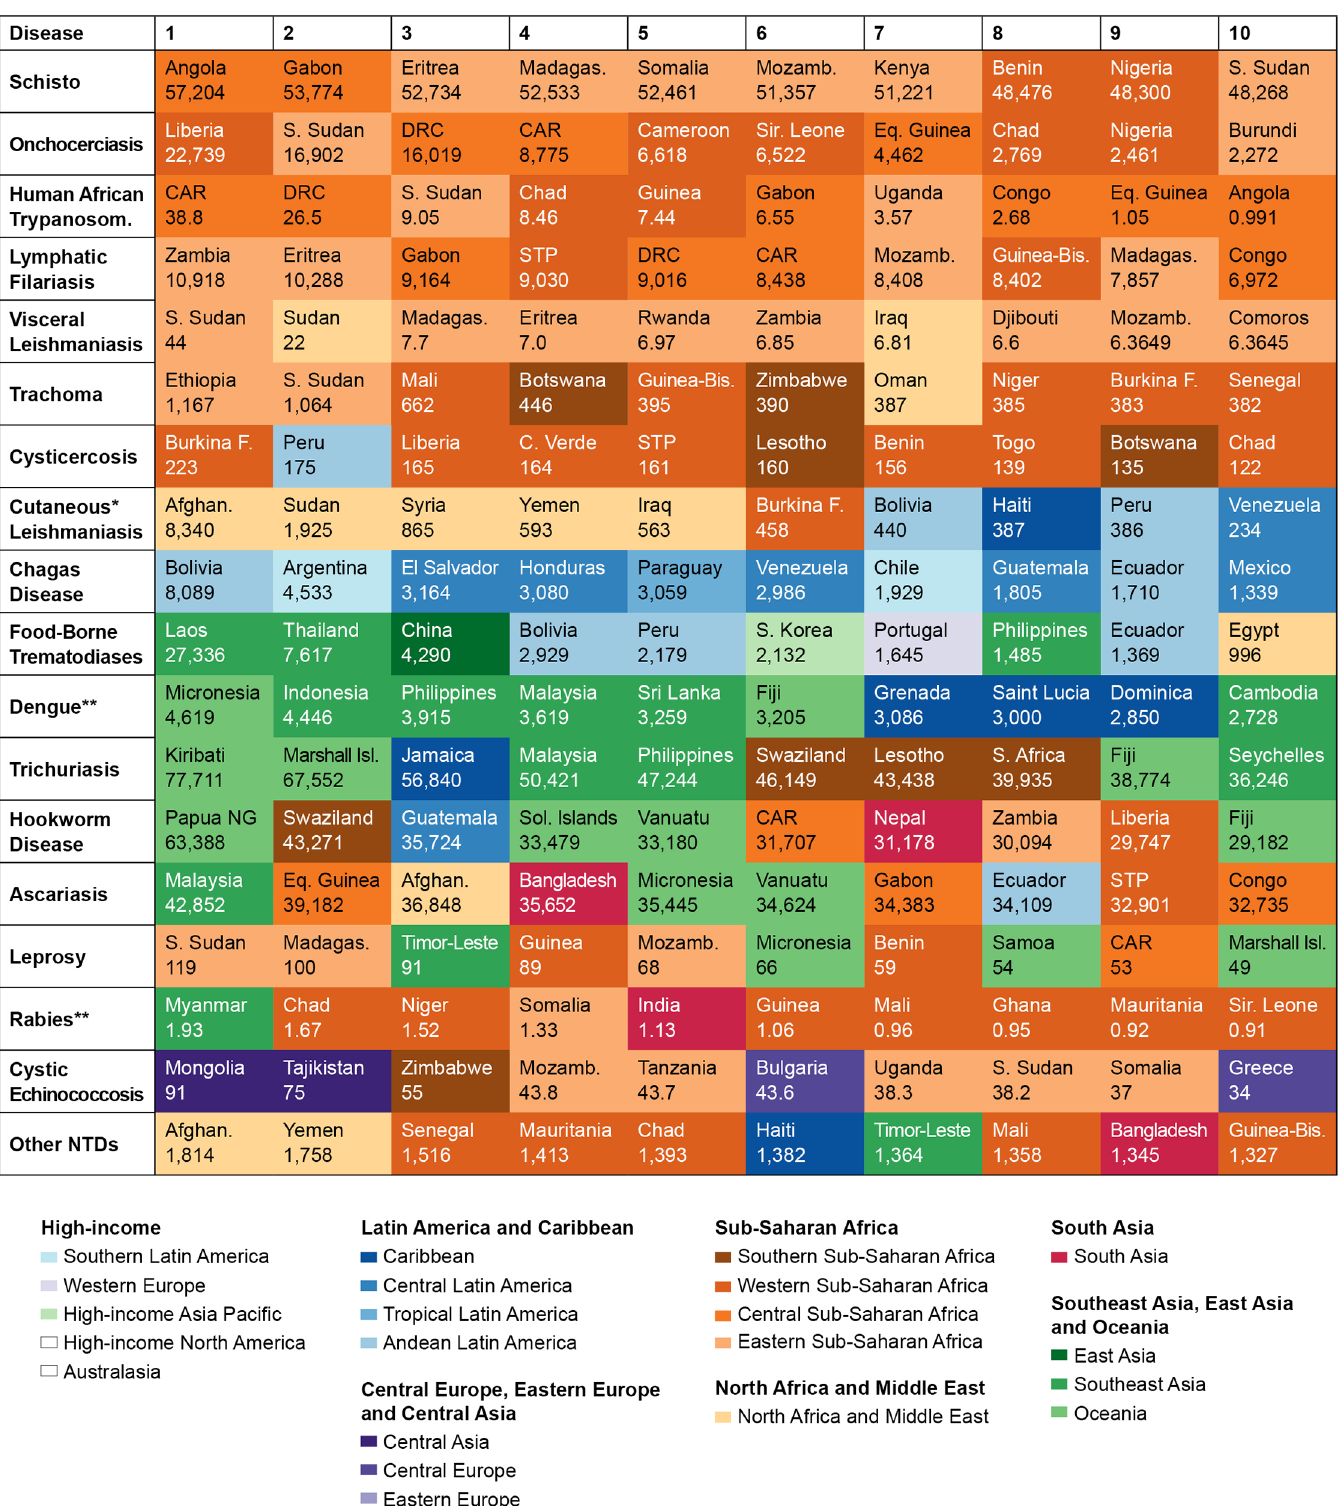
Fig 3. Countries with highest NTD prevalence in 2013. Countrieswith the highestprevalence (per 100,000population)for the diseasesindicatedand the estimated prevalencein each country. Countriesare color coded by Global Burden of Disease Study (GBD) regions. Abbreviations: CAR, CentralAfrican Republic; DRC, Democratic Republicof the Congo; STP, S ã o Tome´ and Principe. * Also includesmucocutaneous leishmaniasis, ** Incidence rather than prevalence. https://doi.org/10.1371/journal.pntd.0005424.g003 PLOS NeglectedTropical Diseases | https://doi.org/10.1371/journal.pntd.0005424 August 3,